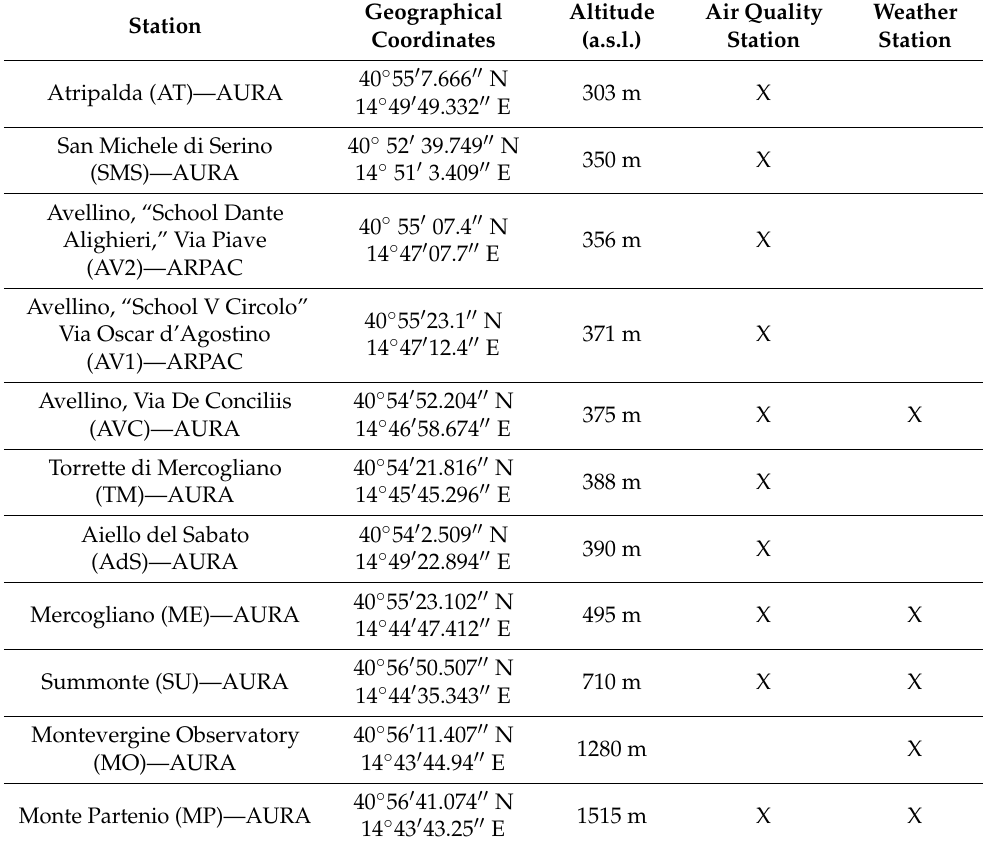
Table 1. List of monitoring stations used in the study. For each site coordinates, altitude and type of station (air quality and/or weather station) are